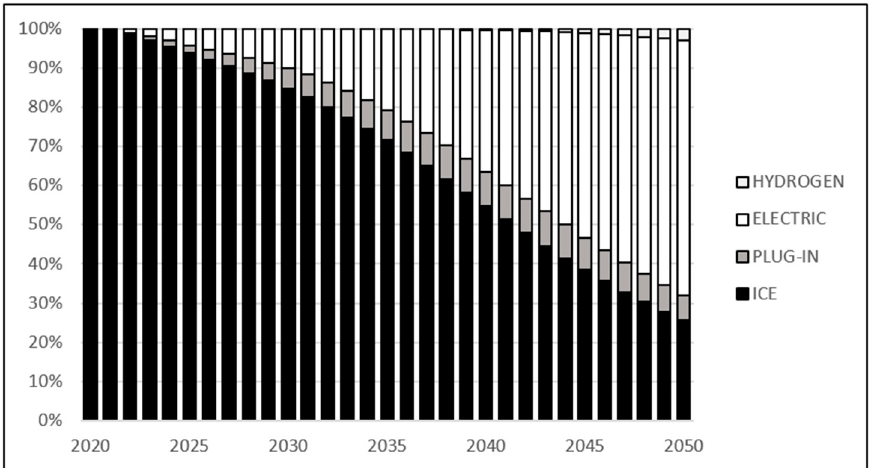
Figure 7. Structure of passenger cars in Poland in the years 2020–2050 by engine type [NEU scenario]. Source: own calculations based on TR 3 E model results.